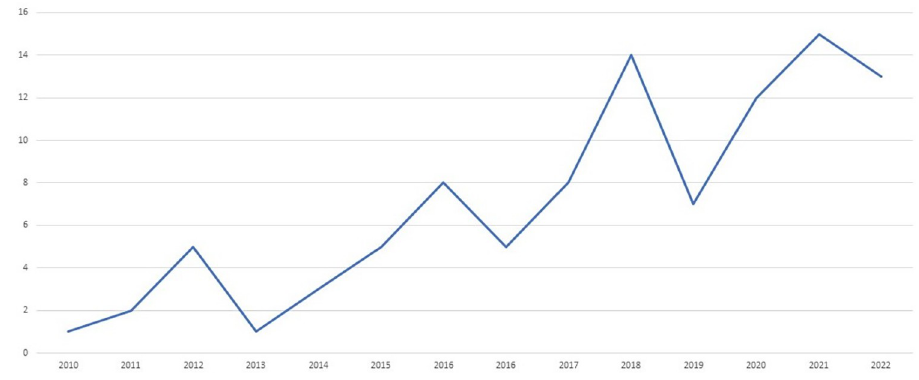
Fig 2. Annual production of evidence on digital health in fragile states in the MENA